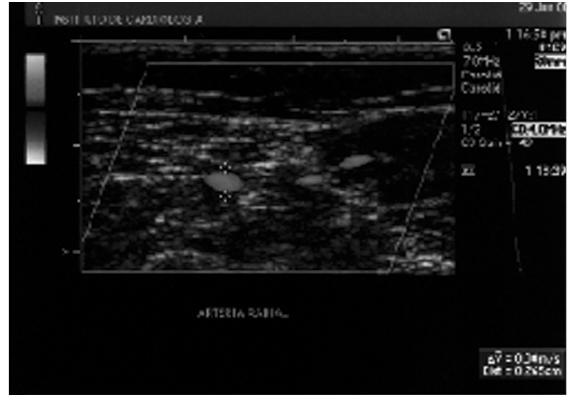
Fig. 2 – Diâmetro interno da artéria radial maior que